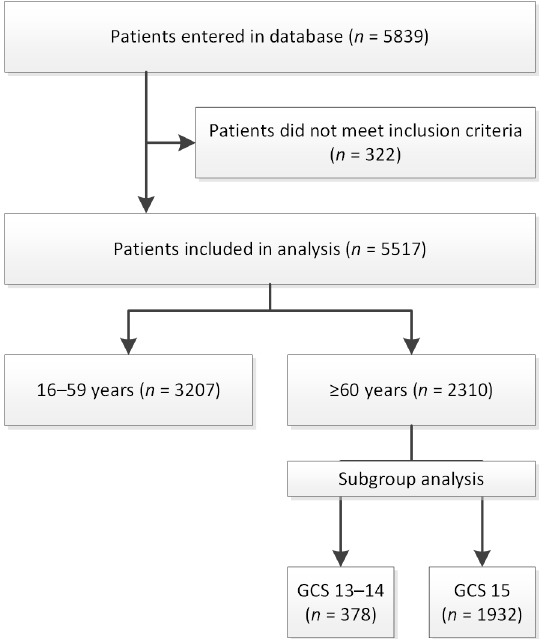
Figure 1. Study flowchart. GCS = Glasgow Coma Scale. Table 1. Demographics and trauma characteristics of younger versus older patients at the ED after